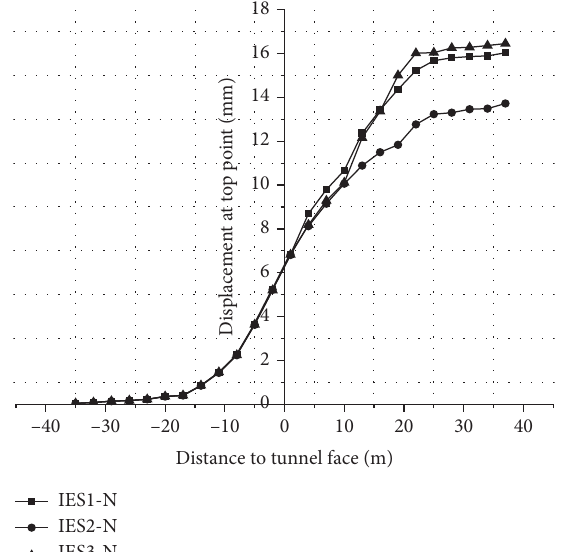
Figure 9: Three curves of the displacement at the top point of tunnel